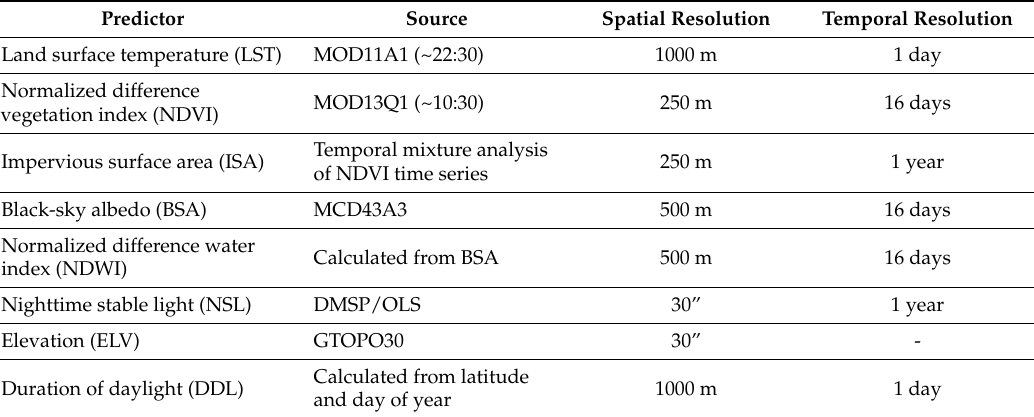
Table 1. Predictors used for Ta